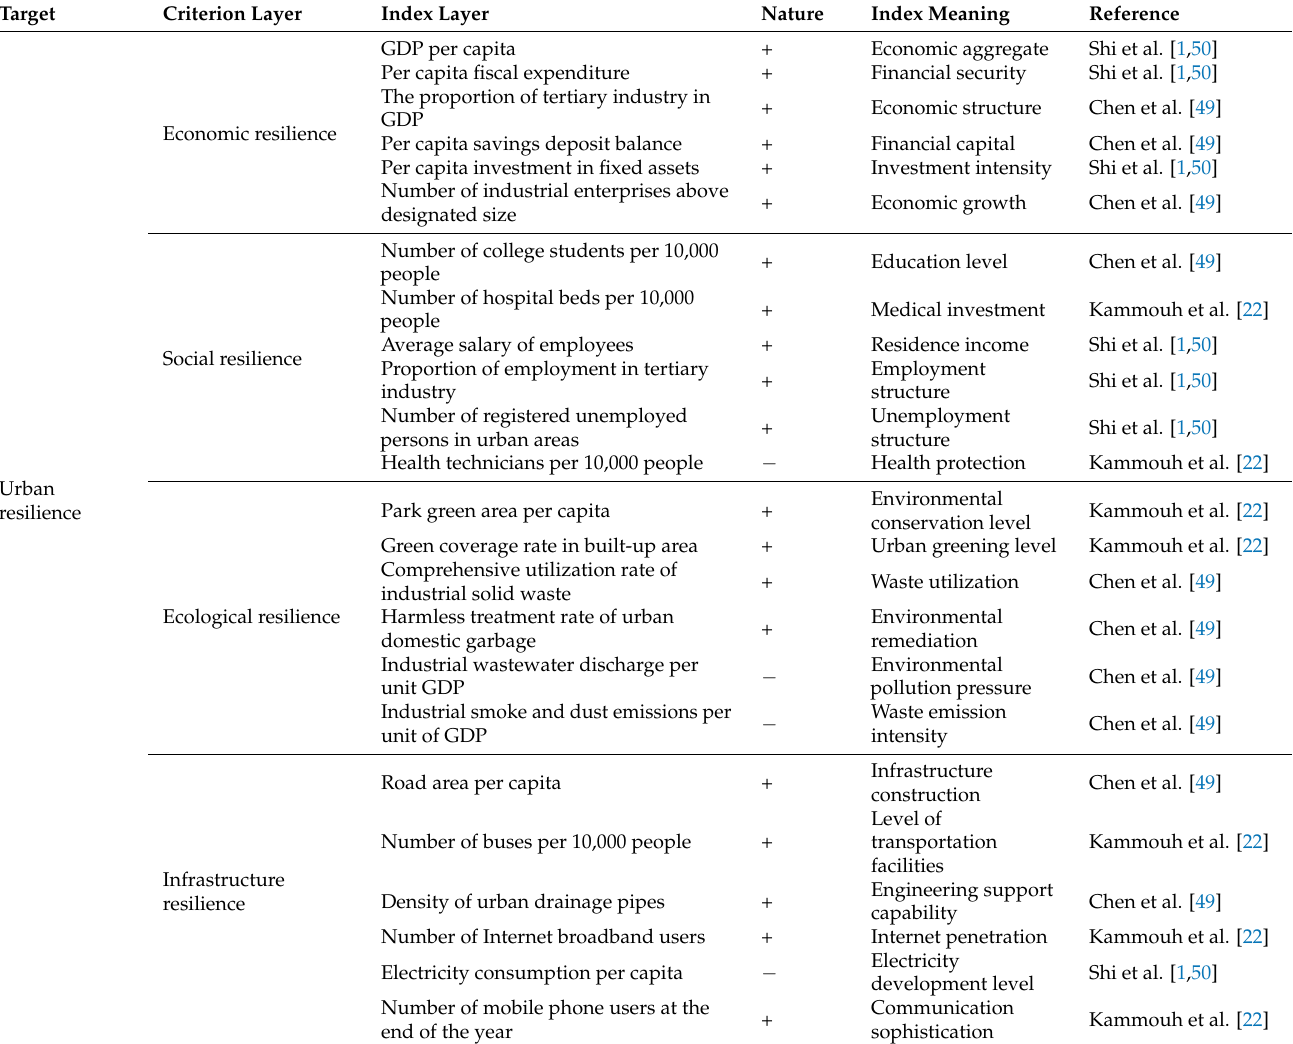
Table A1. The evaluation index system of urban resilience in the